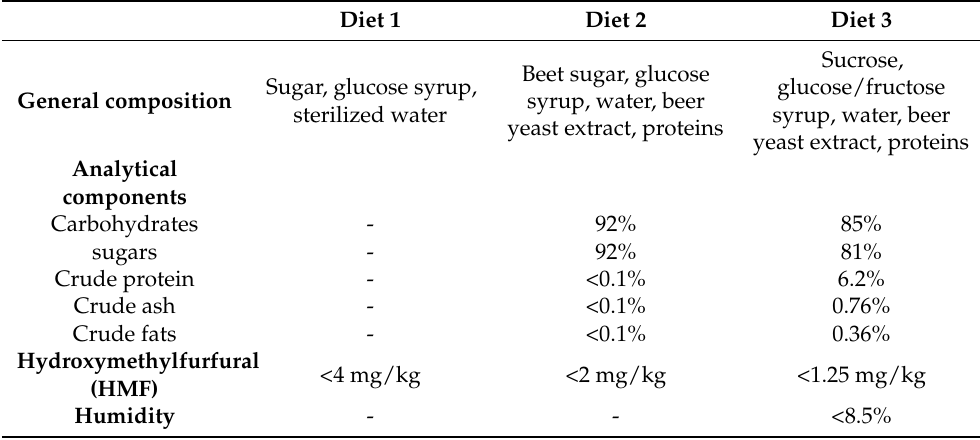
Table 1. Composition of the three experimental diets (diet 1, diet 2, diet 3) reported on commercial